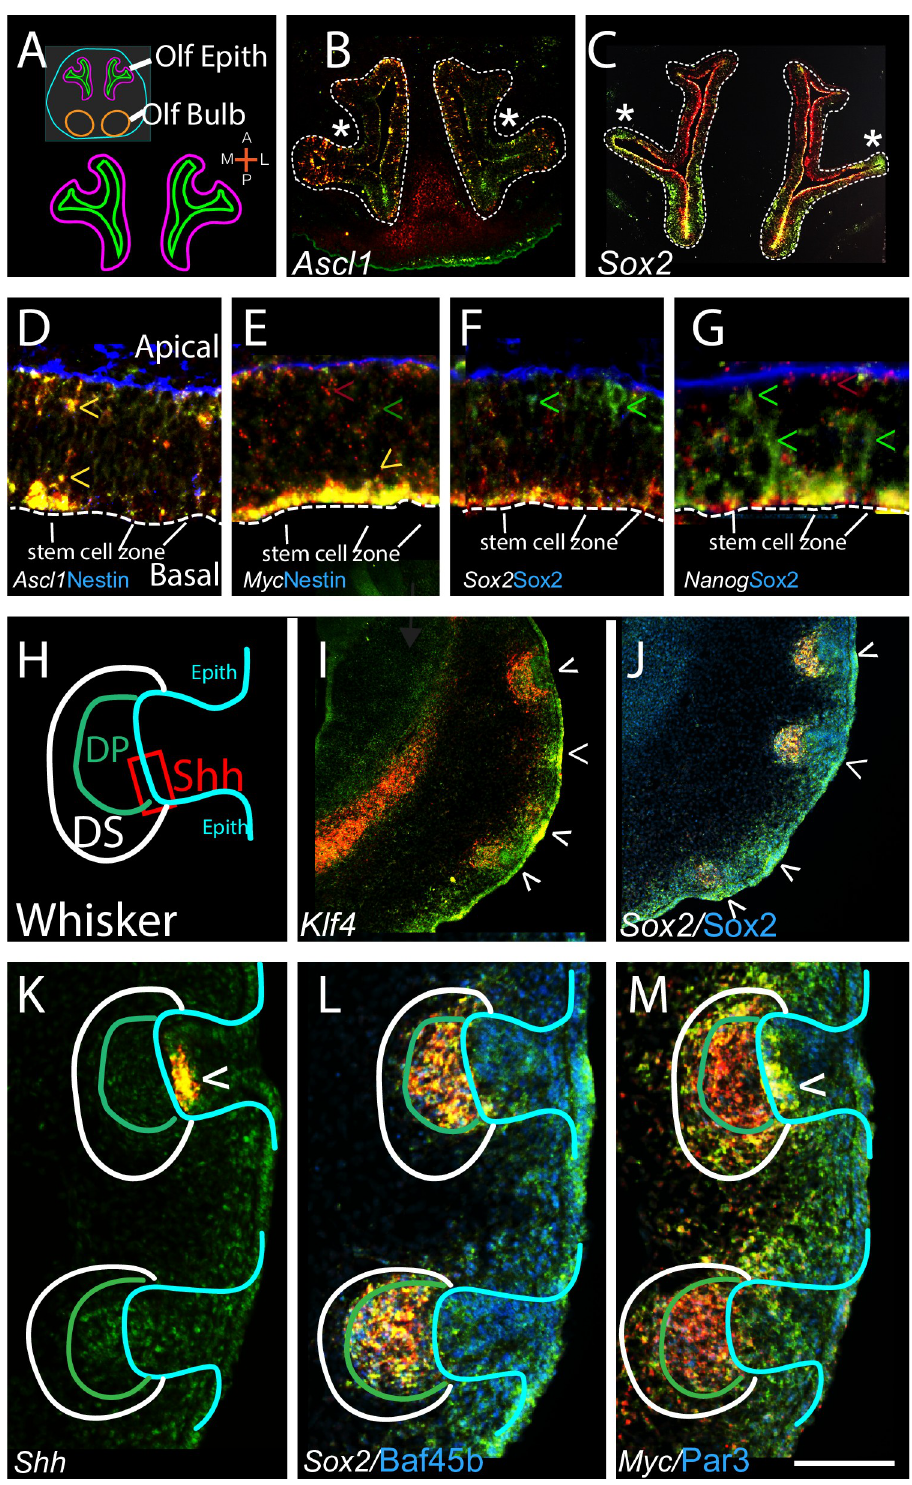
Fig 2. Progenitor cells show distinctive 3’UTR/CDS patterns. (A) Schematic showing horizontal view of E12 olfactory epithelium (OlfE). (B,C) similar sections of E12 OlfE with control pro-neural gene Ascl1 and PpG gene Sox2 . Ascl1 is expressed in scattered cells, often with colocalized 3’UTR/CDS expression, while Sox2 shows graded differential 3’UTR/CDS expression across OlfE regions. � denotes symmetrical patterns in contralateral OlfE for each